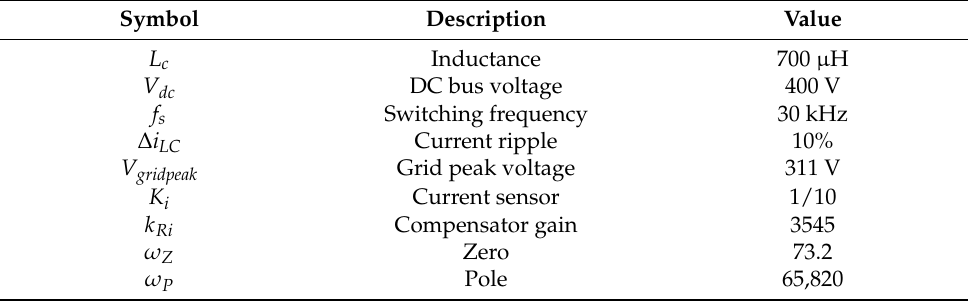
Table 2. Main active power filter (APF) parameters.